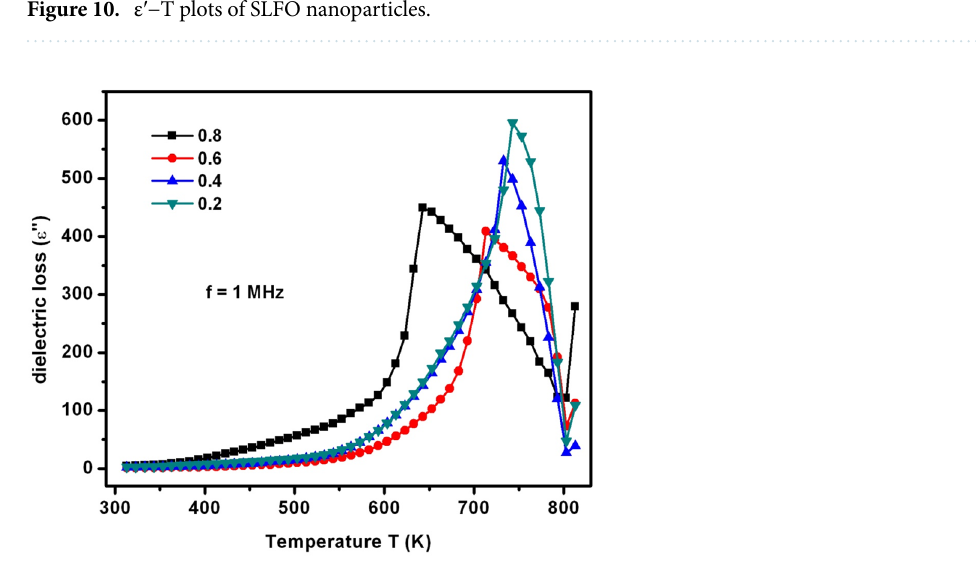
Figure 10. ε ′ −T plots of SLFO nanoparticles.